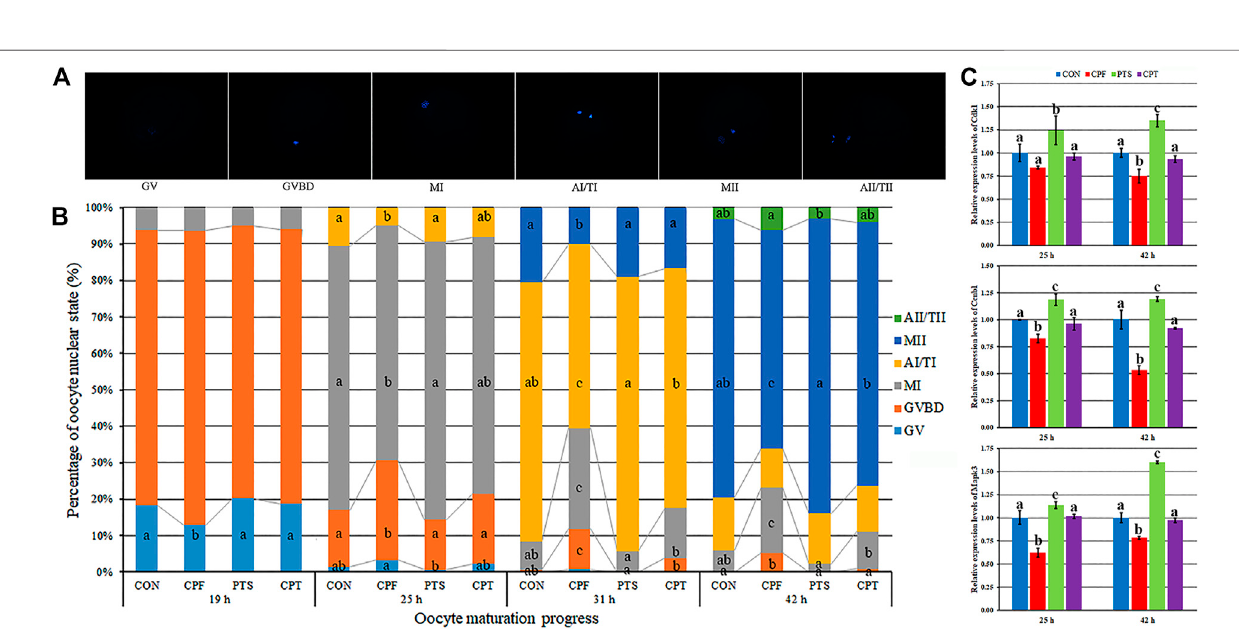
Frontiers in Cell and Developmental Biology |